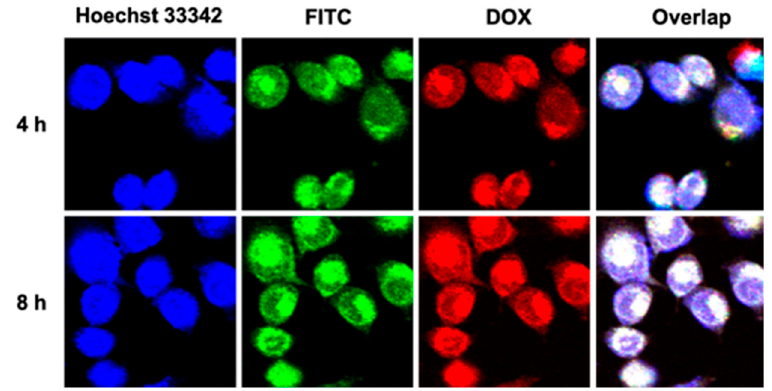
Figure 5. Confocal images of MCF-7 cells after being treated by DOX/BSA NPs for 4 and 8 h. The blue fluorescence showed cell nuclei were stained with Hoechst 33342. The green fluorescence represents FITC, which was labeled on BSA.